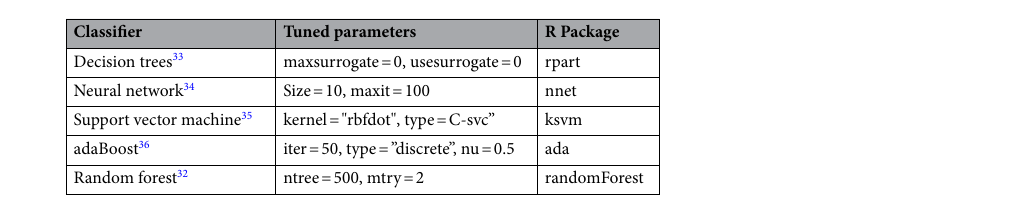
Table 4. Illustration of ML classifiers used for